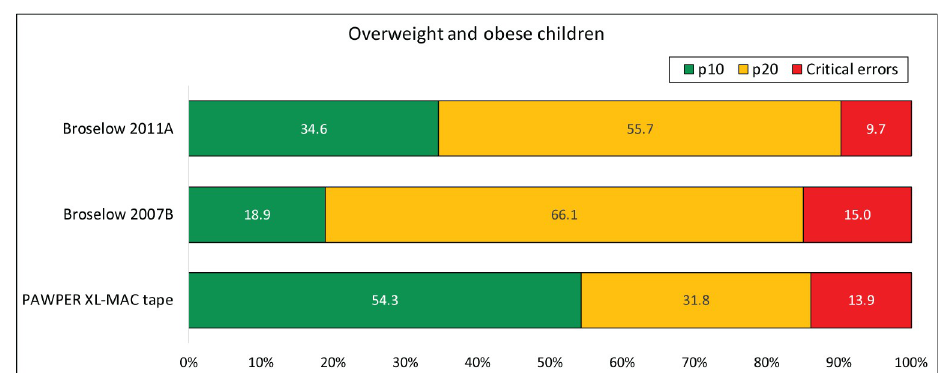
Fig 6. Accuracy of the three systems in overweight and obese children. The chart shows the proportion of weight estimations falling within 10% and 20% of actual weight (p10 and p20 respectively) as well as the proportion of critical weight estimation errors ( > 20% error) for children with a BMI-for-age Z-score greater than 1.4. This subgroup data was not available for the Ralston method as it information was not presented in the original publication. The McNemar test was significant at the p < 0.001 level for every comparison of p10 and p20. The PAWPER XL-MAC method p10 and p20 were clinically superior to both versions of the Broselow tape. The p10 of the Broselow 2011A was clinically superior to the Broselow 2007B, but the p20 of the Broselow 2007B was clinically superior to the Broselow 2011A.